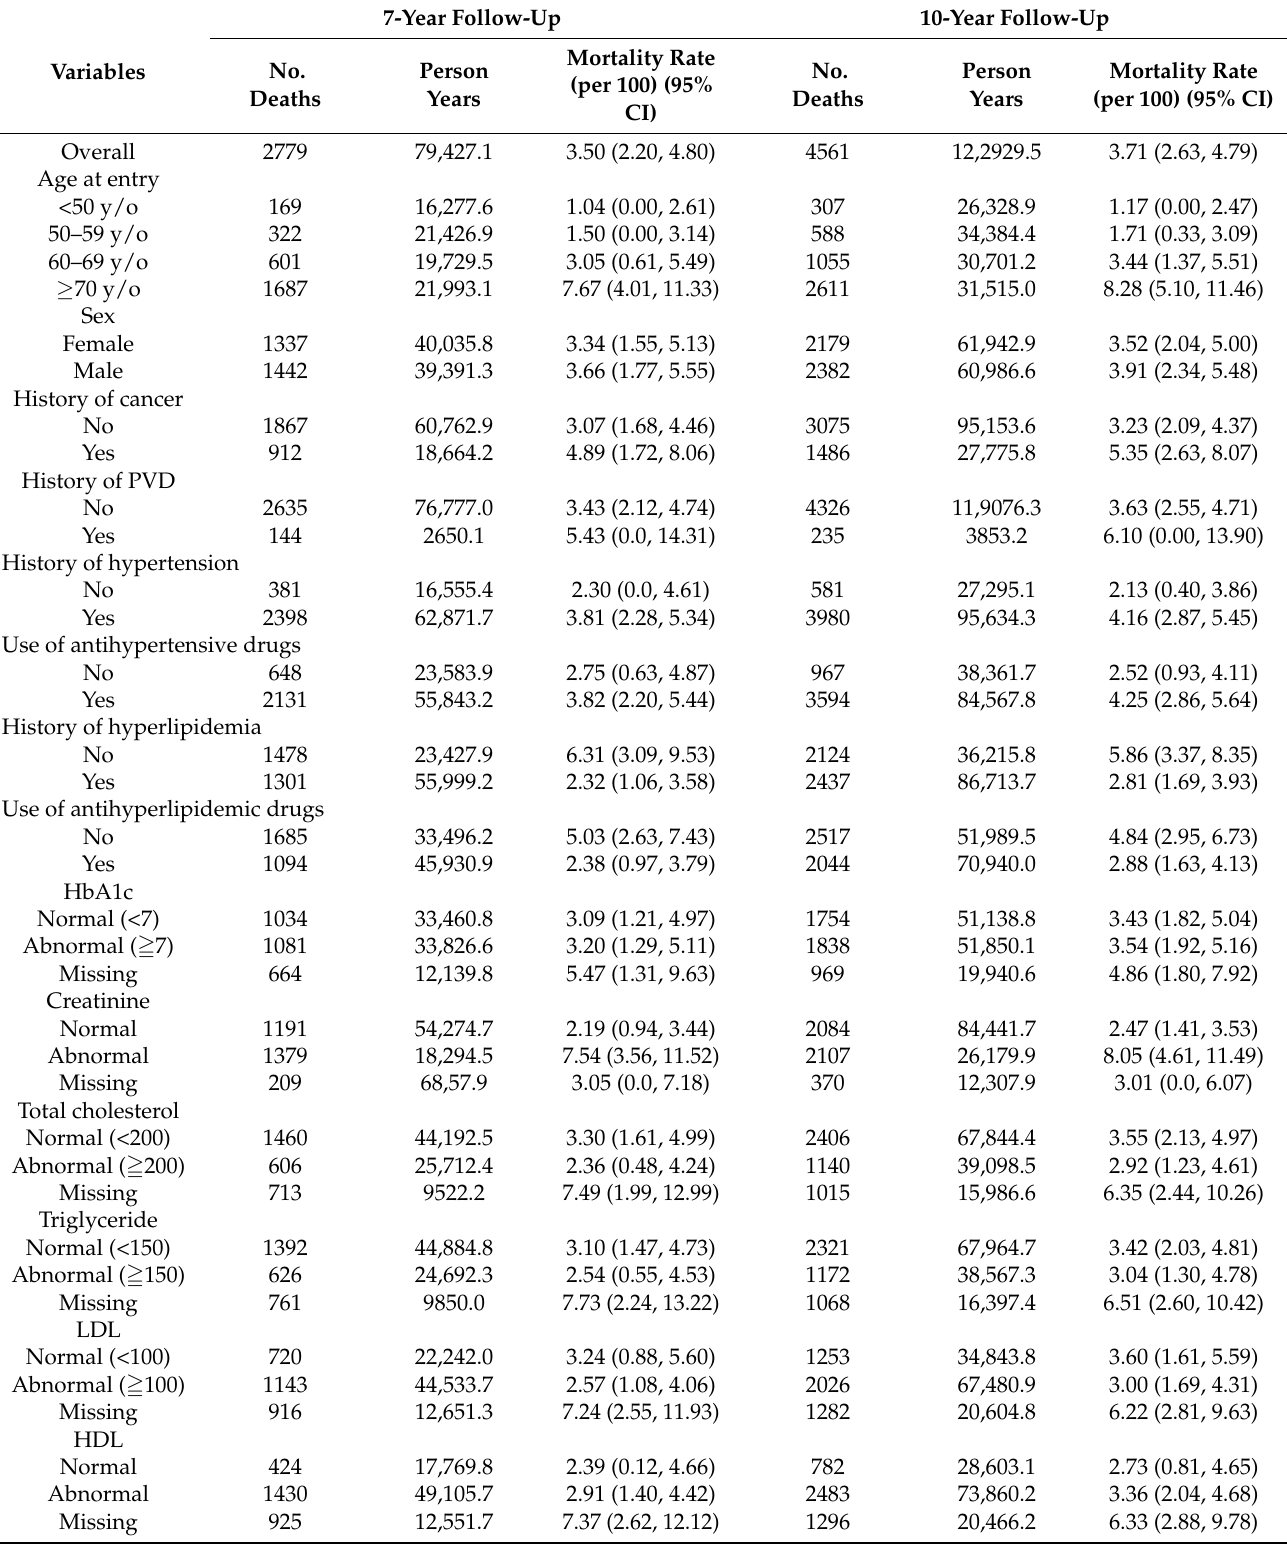
Table 1. All-cause mortality rates of persons with type 2 diabetes mellitus by characteristics and risk factors.